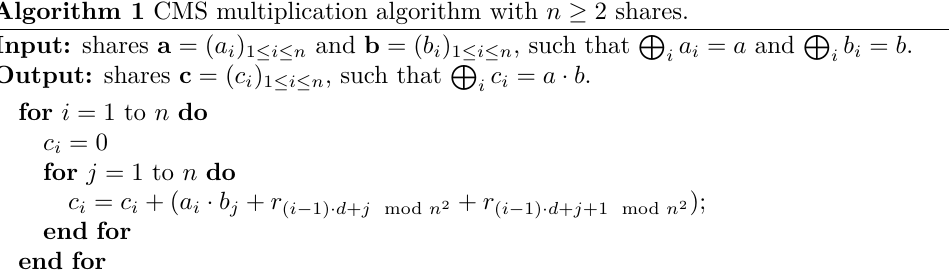
Algorithm 1 CMS multiplication algorithm with n ≥ 2